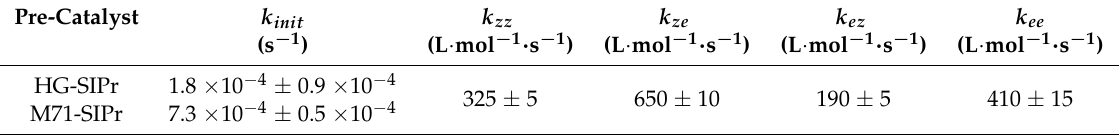
Figure 5. Active species formed from HG-SIPr and, M71-SIPr pre-catalysts. R stands for A or B fragments. Table 2. Kinetic parameters obtained in the case of isopropyl-substituted NHC ligands at 40 ◦ C. Pre-Catalyst